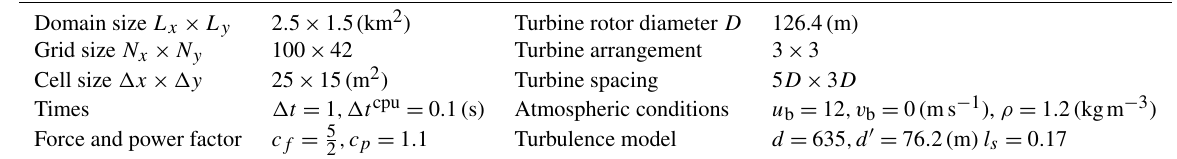
First row: WFSim (black) and SOWFA (blue dashed)